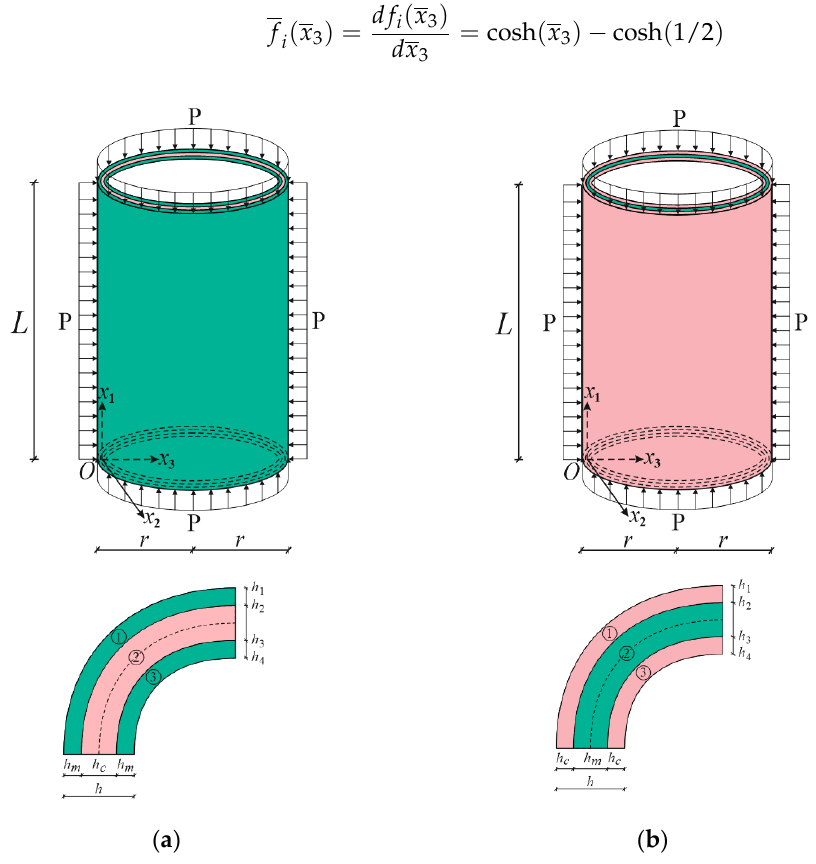
Figure 4. ( a ) M/C/M and ( b ) C/M/C cylindrical shells under hydrostatic pressure and their cross sections.